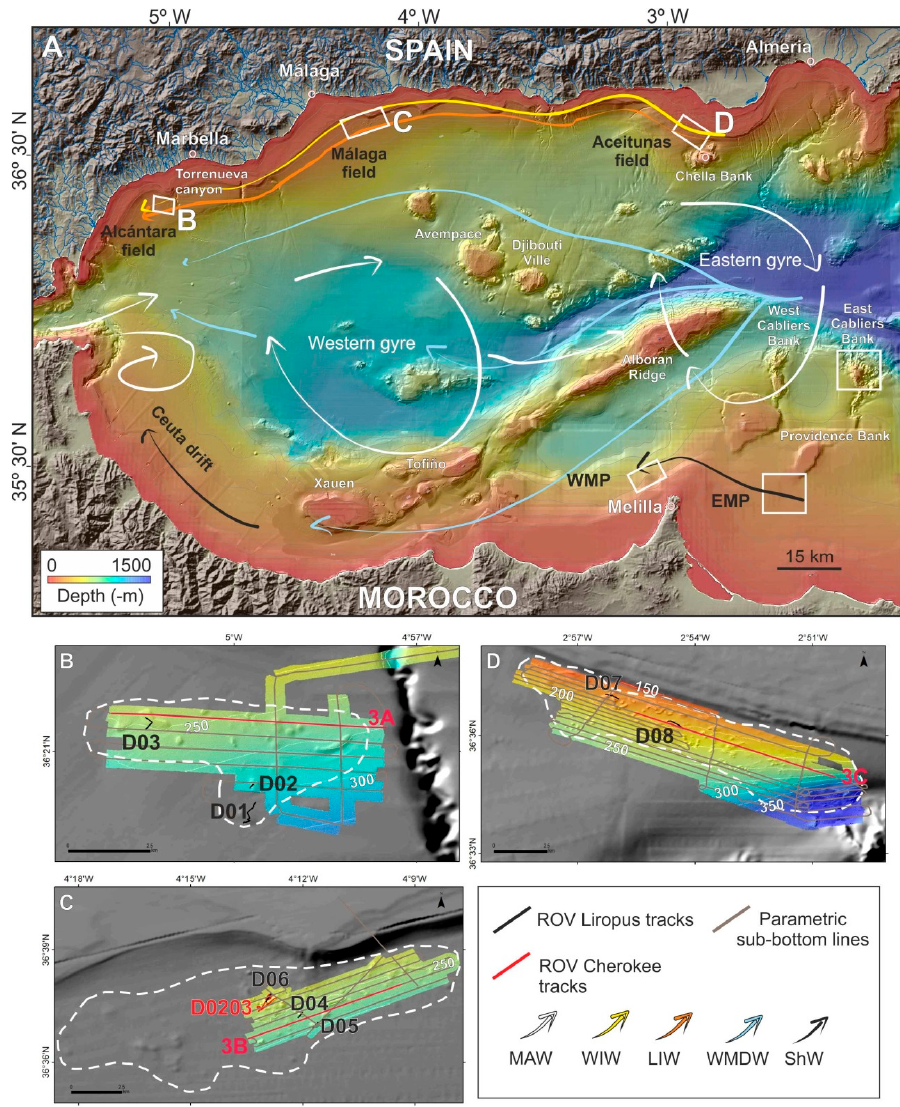
Figure 1. ( A ) Overview map showing the three carbonate mound fields ( B – D ) on the northern margin of the Alboran Sea described in this study and the location of cold-water corals (CWC) mound provinces detected in the southern Alboran Sea (Cabliers, West Melilla (WMP) and East Melilla (EMP) mound provinces [55,61–63]. The water mass circulation scheme is adapted from [56] based on Legend: MAW, Atlantic Water; WIW, Western Intermediate Water; LIW, Levantine Intermediate Water; WMDW, Western Mediterranean Deep Water; ShW, Shelf Water. Bathymetric map of ( B ) Alc á ntara carbonate mound field; ( C ) M á laga carbonate mound field and ( D ) Aceitunas carbonate mound field showing the location of dive tracks and sub-bottom parametric profiles (lines). Extension of the mound fields are marked by white dotted contours. The black scales represent 2.5 km. Bathymetric contours with 25 m spacing are shown as white